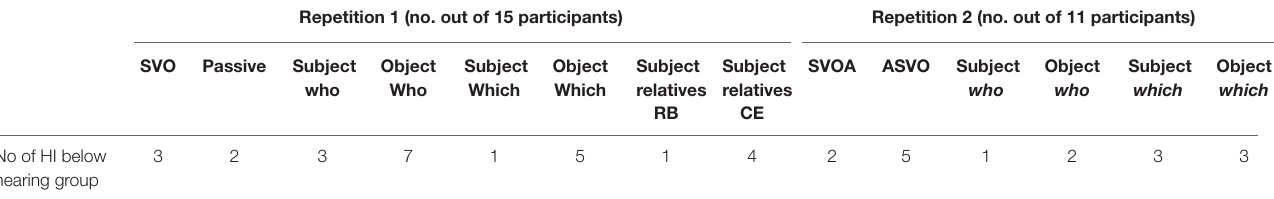
TABLE 6 | Repetition Experiments 3 and 4: number of HI participants performing significantly below the hearing group.